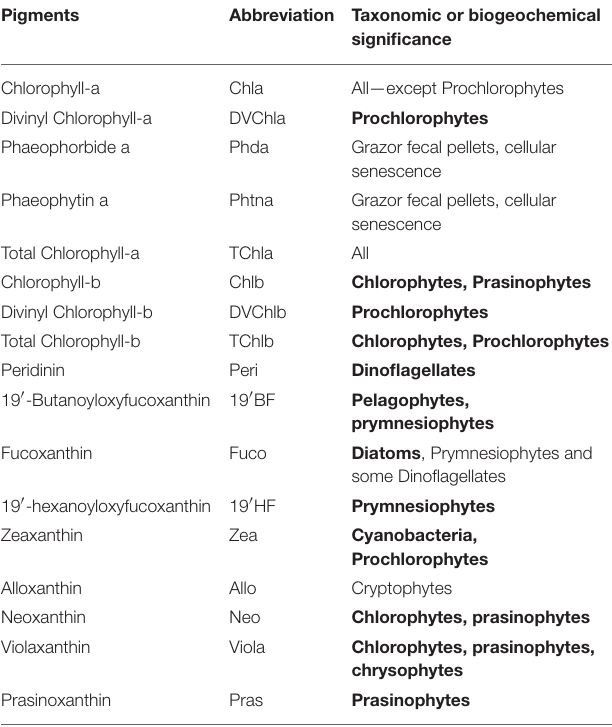
TABLE 1 | List of the pigments and their abbreviations used in this study and their taxonomic/biogeochemical significance [modified from Jeffrey and Vesk